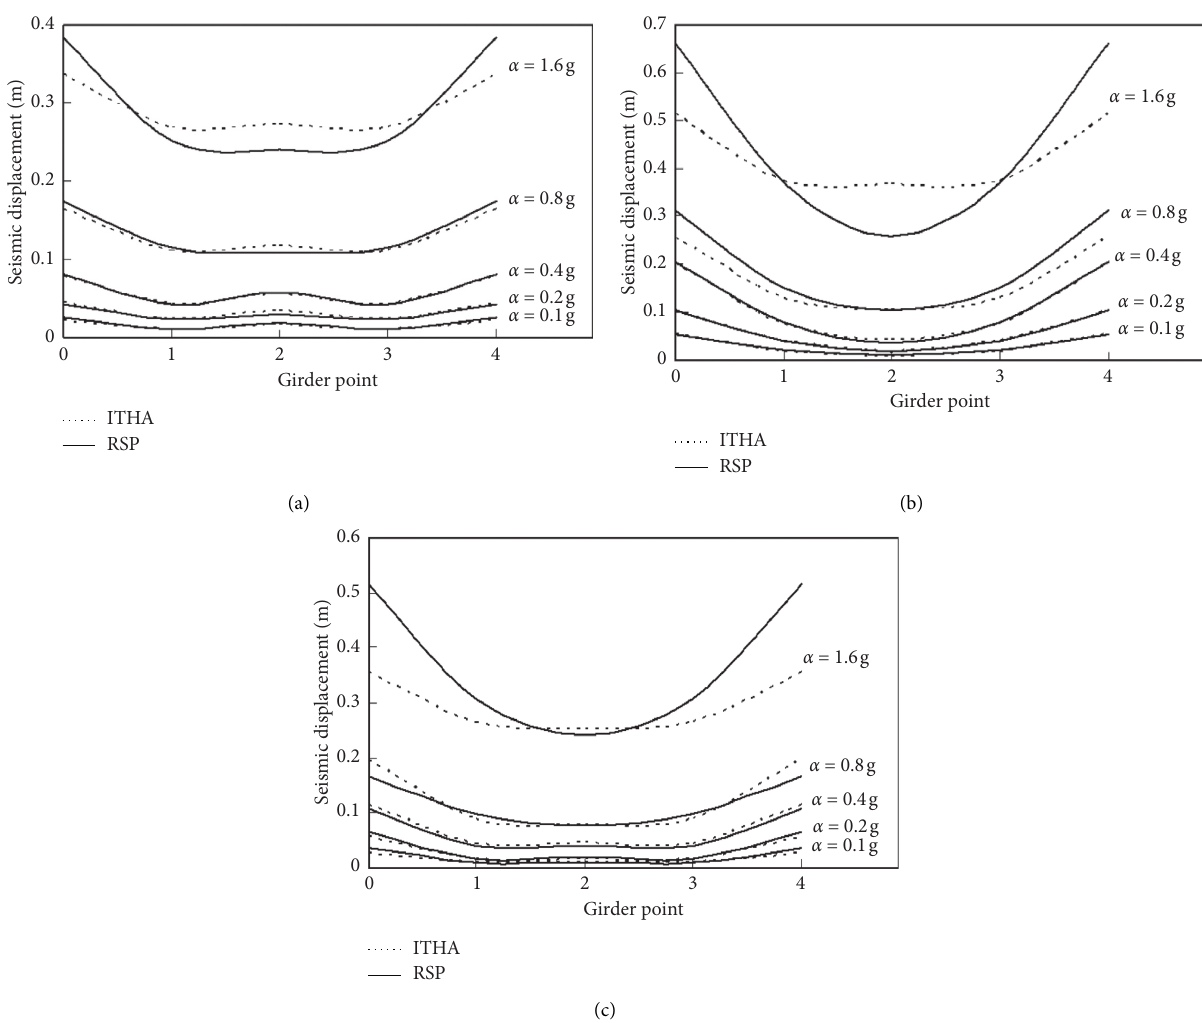
Figure 8: Comparison of seismic displacement by the ITHA and simplified prediction method using RSP: (a) 051005 bridge, (b) 100510 bridge, and (c) 050505